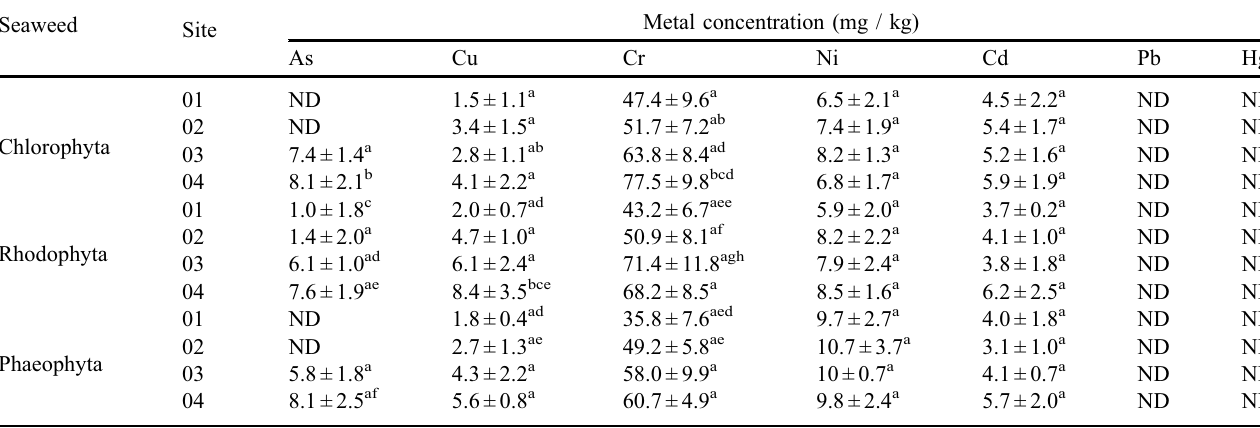
Table 2. Concentration in mg kg − 1 of metals and metalloids in three varieties of seaweeds in different coastal areas of Sri Lanka (cid:1) South Western Monsoon Season.